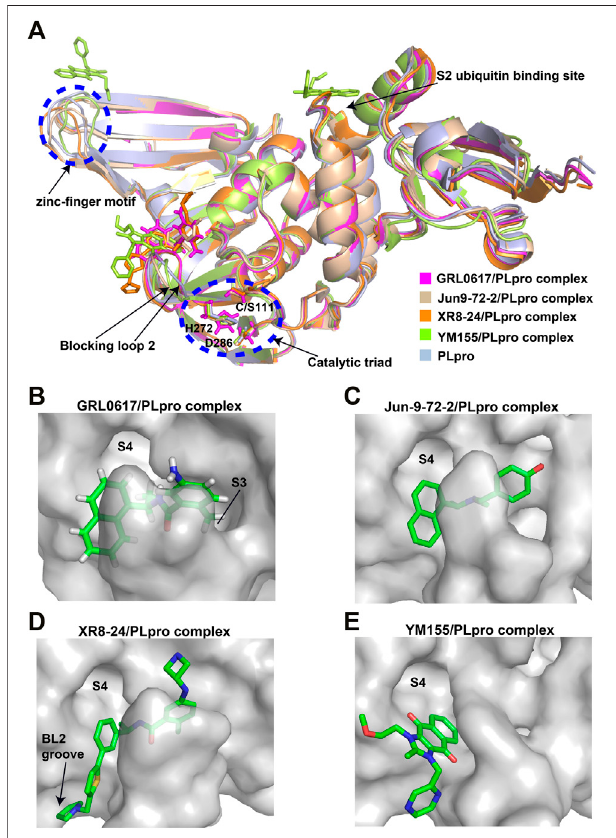
FIGURE 3 | Crystal structure of SARS-CoV-2 PLpro in complex with non-covalentinhibitors. (A) SuperpositionofPLpro(lightblue; PDB ID:6WZU) with GRL0617/PLpro (magentas; PDB ID: 7CMD), Jun9-72-2/PLpro (wheat; PDB ID: 7SDR), XR8-24/PLpro (orange; PDB ID: 7LBS), and YM155/ PLpro(limon;PDBID:7D7L)complexes.Thecatalytictriadandthezinc- fi nger motif are shown in the blue dashed circle. The blocking loop 2 and the S2 ubiquitin binding site are indicated. (B) Surface presentation of GRL0617 binding pocket. PLpro is shown as gray surface, while GR0617 is shown as sticks. S3 and S4 pockets are labeled. (C) Surface presentation of Jun9-72-2 binding pocket. PLpro isshown as gray surface, whileJun9-72-2 isshown as sticks. S4 pocket is labeled. (D) Surface presentation of XR8-24 binding pocket. PLpro is shown as gray surface, while XR8-24 is shown as sticks. S4 pocket and BL2 groove are labeled. (E) Surface presentation of YM155 binding pocket. PLpro is shown as gray surface, while YM155 is shown as sticks. S4 pocket is